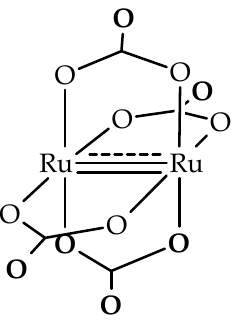
Figure 1. Representation of the [Ru 2 (CO 3 ) 4 ] 3 − anion.